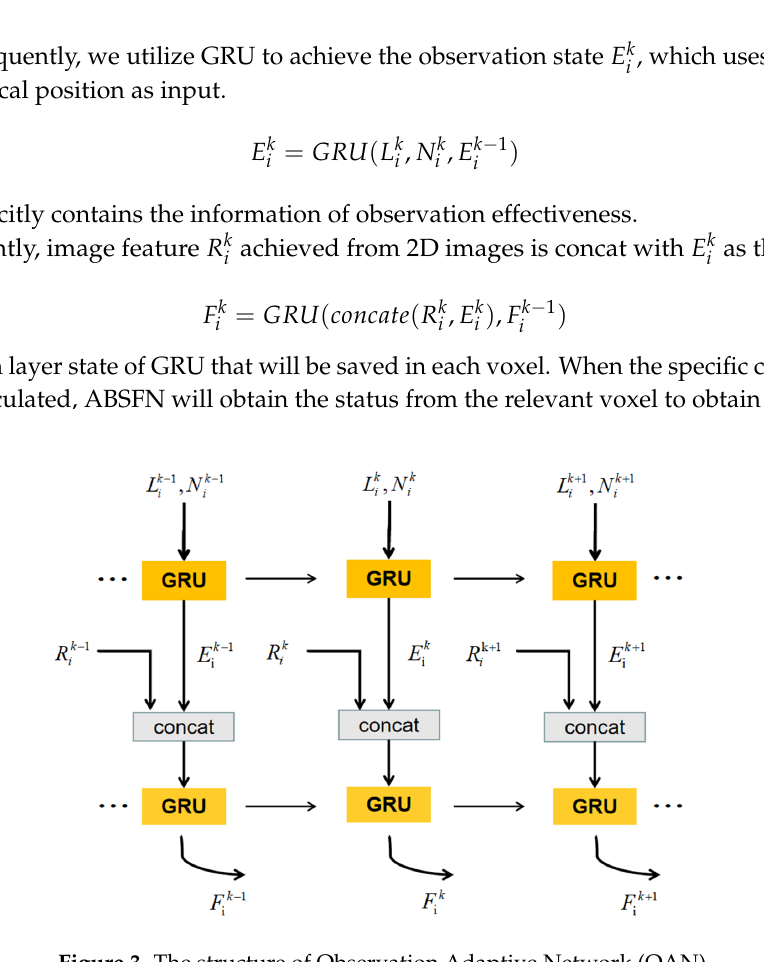
Figure 3. The structure of Observation Adaptive Network